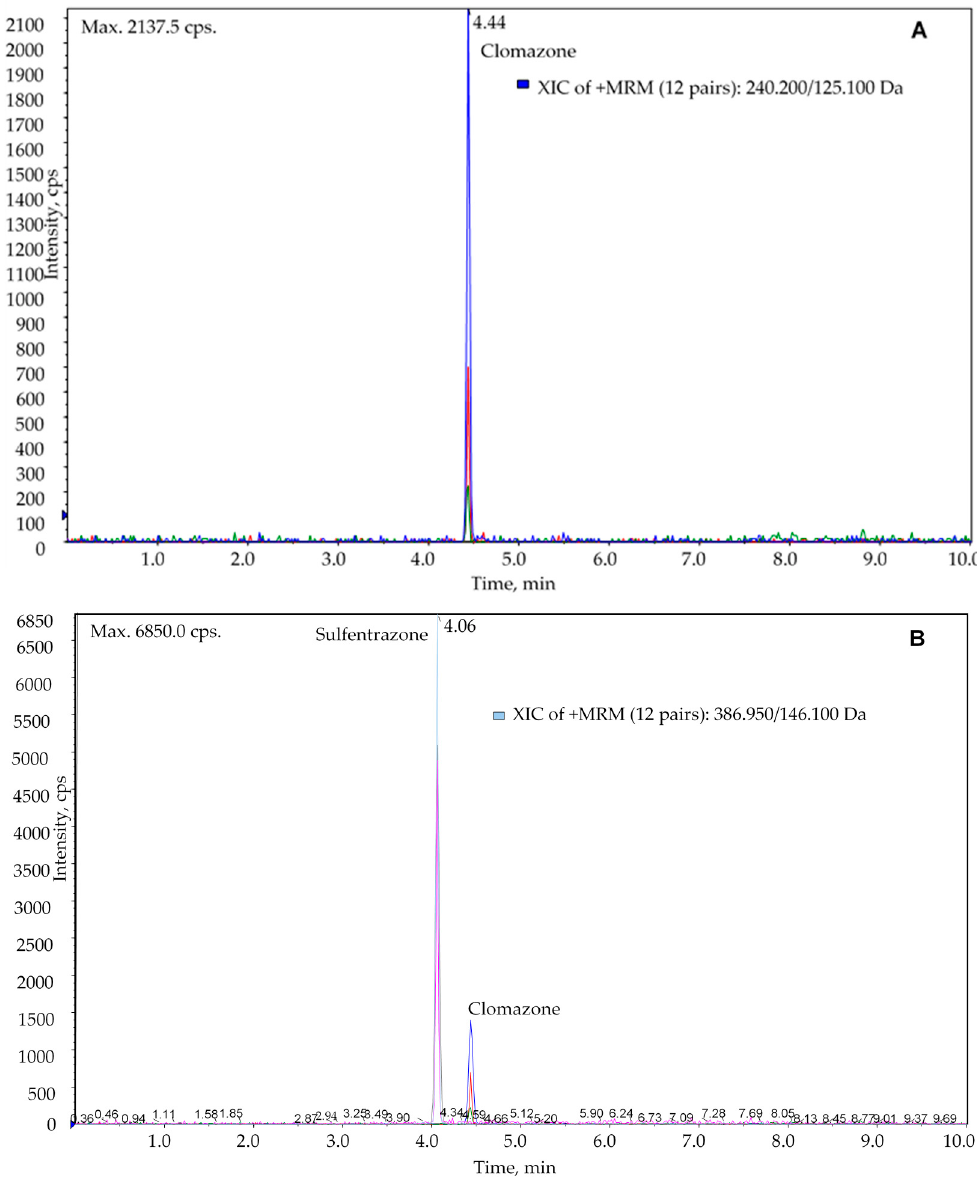
Figure 1. Chromatogram of sample of solutions that percolated the sugarcane straw. Application of clomazone formulations ( A ); application of clomazone formulations combined with sulfentrazone ( B ).